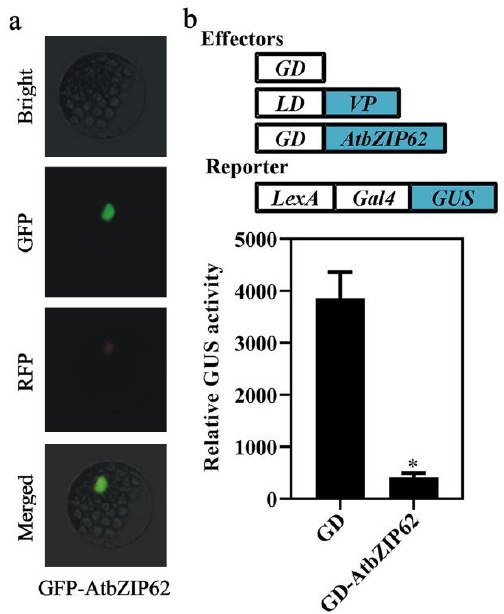
Figure 2. Subcellular localization and transcriptional activities of AtbZIP62. ( a ) Subcellular localiza- tion of AtbZIP62. Plasmids of the effector GFP-AtbZIP62 and the nuclear marker gene NLS-RFP were co-transfected into Arabidopsis protoplasts isolated from leaves of the Col wild-type plants. The transfected protoplasts were incubated in the dark at room temperature for 20–22 h, and GFP and RFP fluorescence was observed and photographed under a confocal microscope. ( b ) Transcriptional activities of Arabidopsis AtbZIP62. Plasmids of the GD-AtbZIP62 effector, the LD-VP activator, and the LexA-Gal4:GUS reporter constructs were co-transfected into Arabidopsis protoplasts isolated from the Col wild-type plants, the transfected protoplasts were incubated in darkness for 20–22 h, and then GUS activity was assayed by using a microplate reader. Co-transfection of the GD construct plasmids served as a control. Data represent the mean ± SD of three replicates. * significantly different from the GD control (student’s t -test, p <